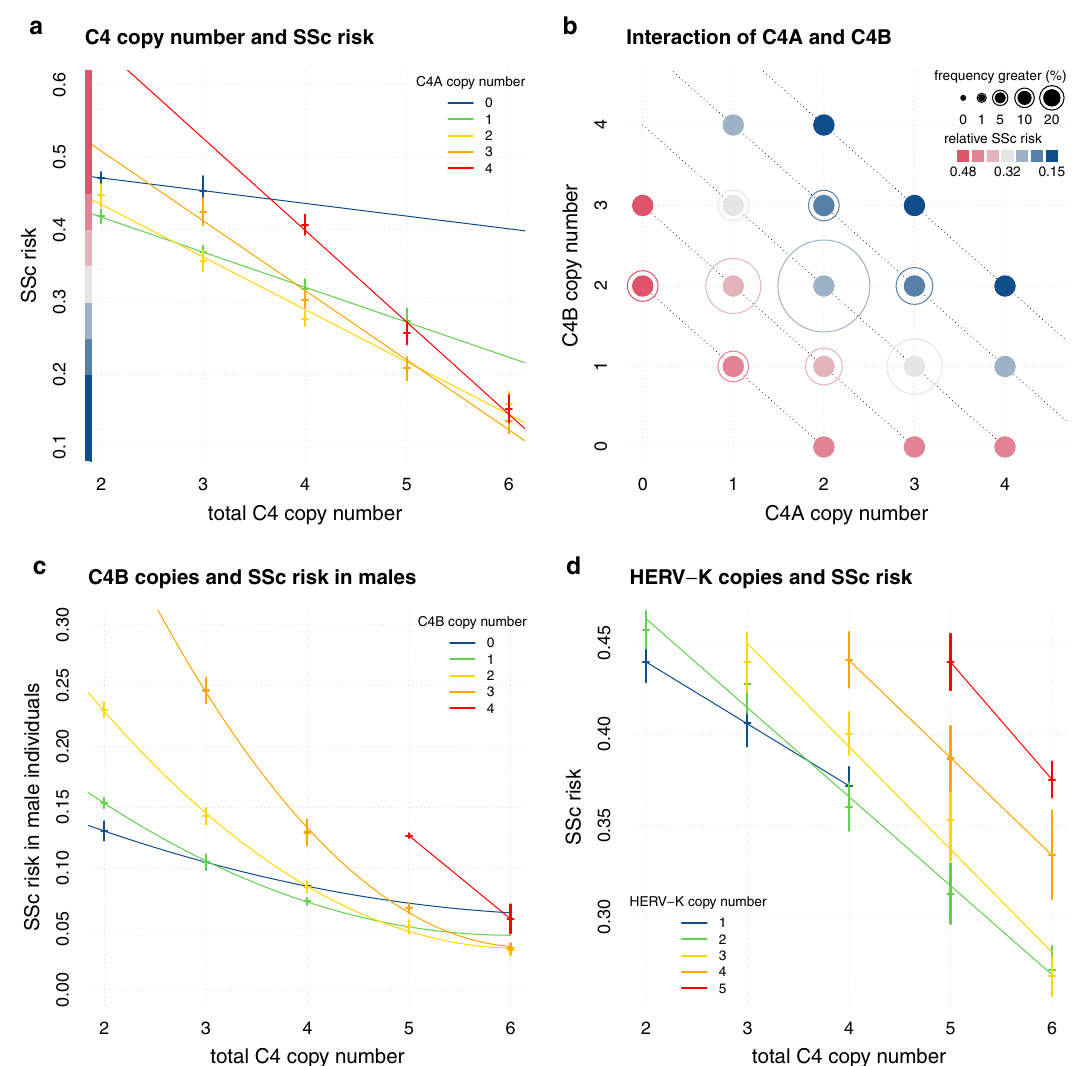
Fig. 1 C4 and HERV-K copy numbers and Systemic Sclerosis risk. a depicts relative systemic sclerosis (SSc) risk vs total C4 copy number strati fi ed by C4A CN. The SSc risk score is calculated per individual as the sum of effect sizes (betas) multiplied with the design matrix. Betas of C4A , C4B and C4A : C4B were taken from the most complex model “ d ” (see “ Methods ” ). Crosses are calculated as average relative risk per rounded C4 CN + / − 2 standard deviations ( y axis). Linear regression lines are colored by C4A CN and drawn to visualize the interaction effect of C4A and C4B . The y axis contains a color code to aid a comparison with ( b ). b depicts the relative SSc risk of combinations of C4A and C4B CNs. Relative risk is calculated as in ( a ). Outer circles are drawn according to population frequency ranges of each C4A, C4B combination and highlight more common combinations. Diagonal dotted lines help to identify combinations of equal total C4 CN. c depicts relative SSc risk in male individuals vs total C4 CN strati fi ed by C4B CN. Relative risk is calculated like in ( a ) using effect sizes of C4A , C4B , C4A:C4B , Sex:C4A , and Sex:C4B . Crosses are calculated as average relative risk per rounded C4 CN + / − 2 standard deviations ( y axis). Cubic regression lines are colored by C4B CN and drawn to visualize the interaction effect of C4A and C4B . d depicts relative SSc risk vs total C4 CN strati fi ed by HERV-K CN. Relative risk is calculated like in ( a ) using effect sizes of C4A , C4B , C4A:C4B , HERV-K:C4A , and HERV-K:C4B . Crosses are calculated as average relative risk per rounded C4 CN + / − 2 standard deviations ( y axis). Linear regression lines are colored by HERV-K (AS, AL, BS, BL) instead of C4A plus C4B plus total HERV-K CNs. Interestingly, expression models were best if CNs of C4B were included in the model of C4A and vice versa. About 21% (27%) of expression variance of C4A ( C4B ) can be attributed to C4A and C4B CNs (Supplementary Table 4B, C). Using C4A and C4B eQTLs alone, we were able to explain up to 42% ( C4B : 38%) of expression variance with 19 ( C4B : 15) SNPs (Supplementary Table 4B, C). This seems to be the upper bound of